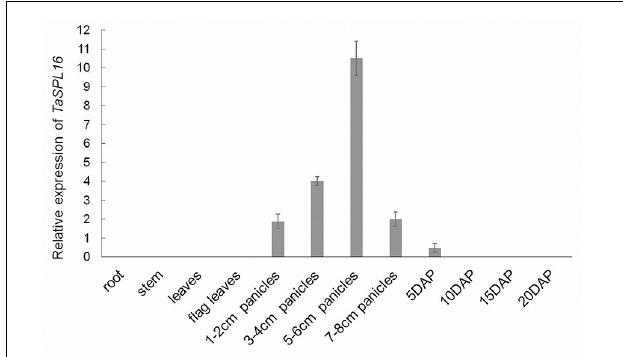
FIGURE 4 | Expression profiles of TaSPL16 in different wheat tissues. Quantitative real-time reverse transcriptase-polymerase chain reaction was conducted to detect total mRNA level of TaSPL16 homoeologs in different tissues, GAPDH (GenBank accession number: EF592180) being used for normalization; DAP means days after